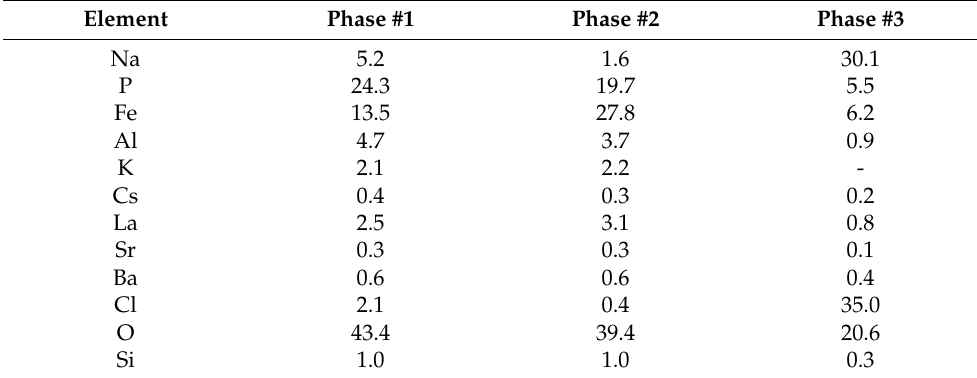
Figure 4. SEM image of ( a ) NAFP glass and ( b ) cleavage surface of the sample after heat treatment at 450 °C. Table 3. The elemental composition (wt%) of NAFP glass after heat treatment at 450 ◦ C.